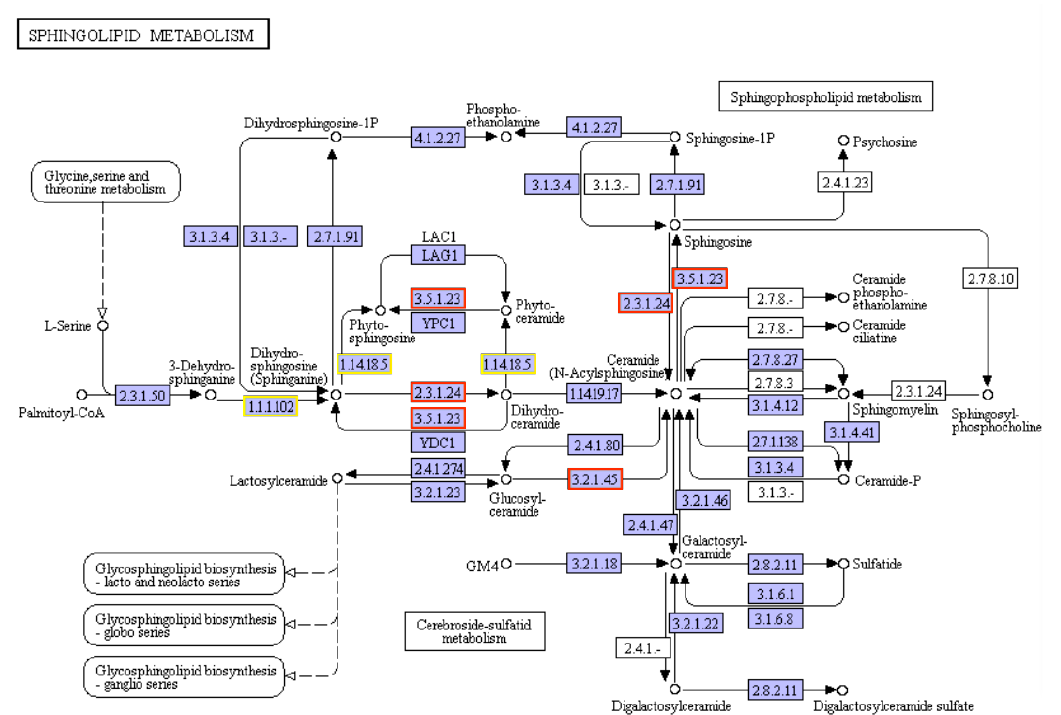
Figure 7. Gene changes in sphingolipid metabolism KEGG pathway. Changes in gene expression of sphingolipid metabolism pathway in KEGG pathway of Pen3a duckweed compared with WT duckweed. Red box shows the enhanced expression, and yellow box shows the mixed regulation of expression. Green box shows the decreased expression (no enzyme has been down-regulated in this figure).